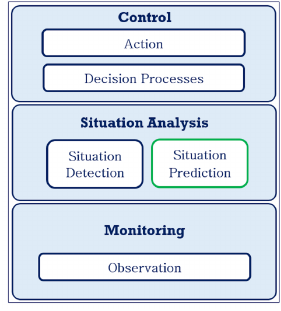
Figure 1. Conceptual model of proposed